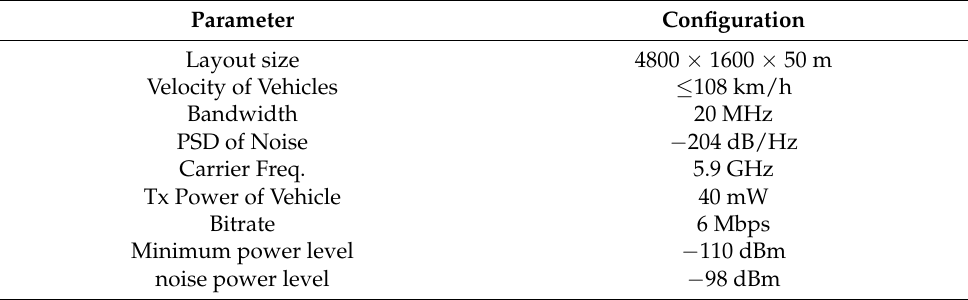
Table 2. Simulation-2 parameter